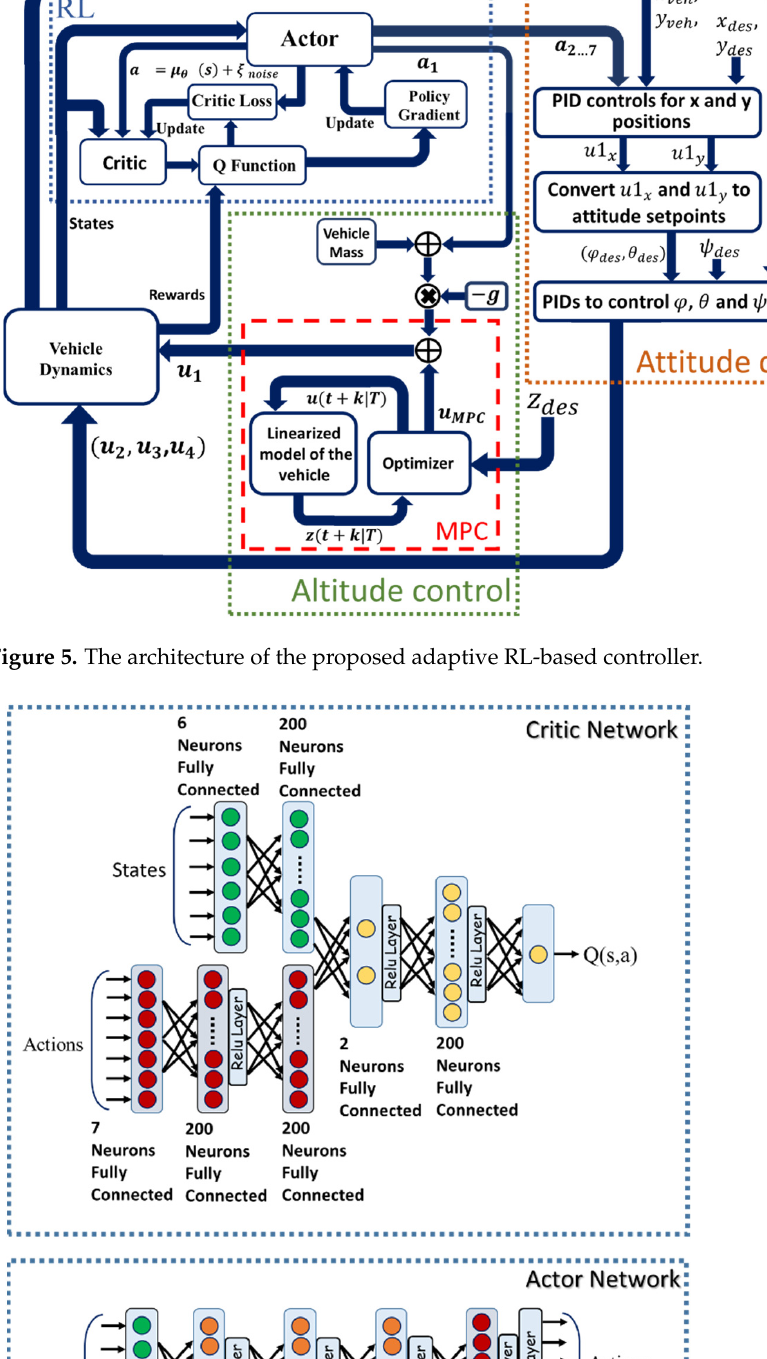
Figure 4. The architecture and learning process of deep deterministic policy gradient.